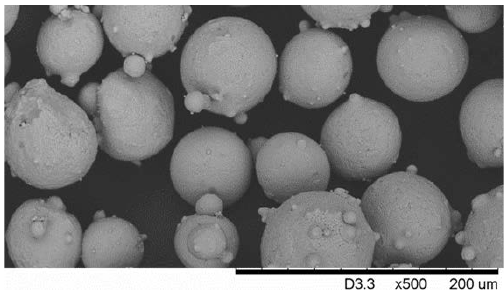
Figure 1. SEM micrograph of virgin 316L stainless steel powder.